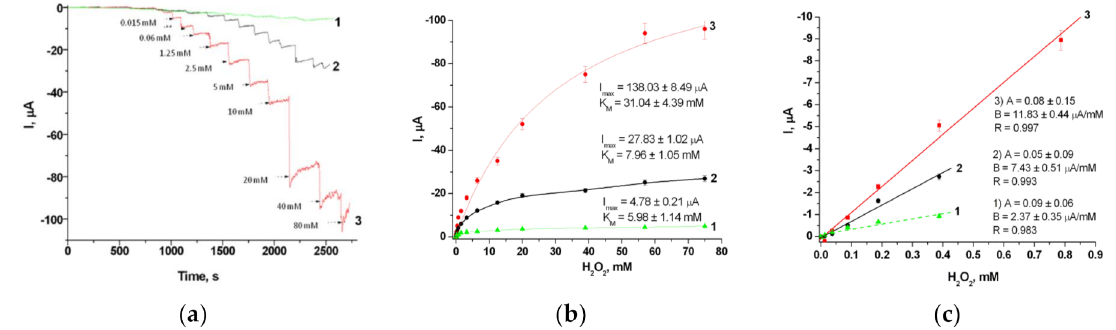
Figure 2. Amperometric characteristics of the modified electrodes: chronoamperograms ( a ), dependences of the response on increasing concentrations of H 2 O 2 ( b ), and calibration graphs ( c ) for PO/GE (1), gFeHCF/GE (2), and gCuHCF/GE (3). Conditions: working potential − 50 mV versus Ag/AgCl (reference electrode), 50 mM NaOAc buffer, pH 4.5 at 23 ◦